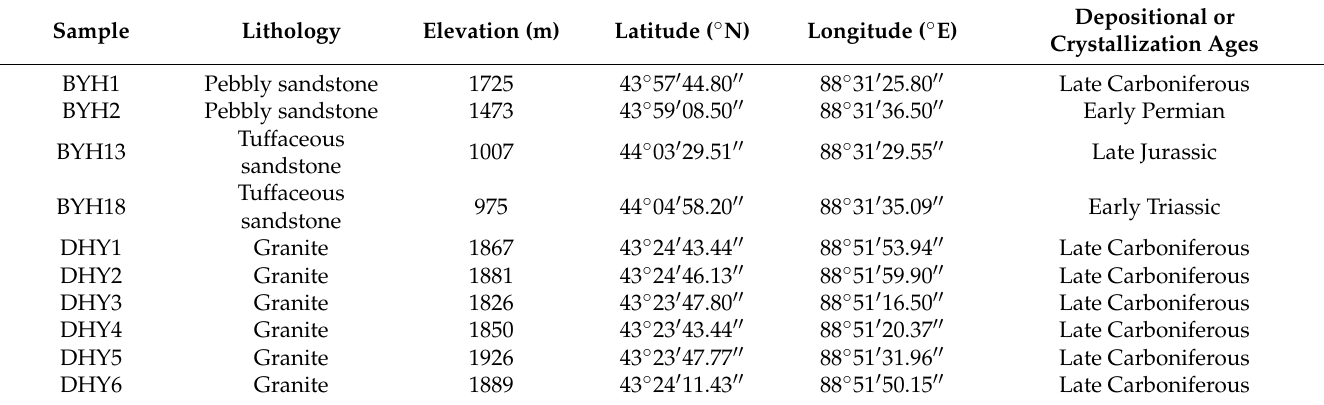
Table 1. Geographic position and lithology details of the